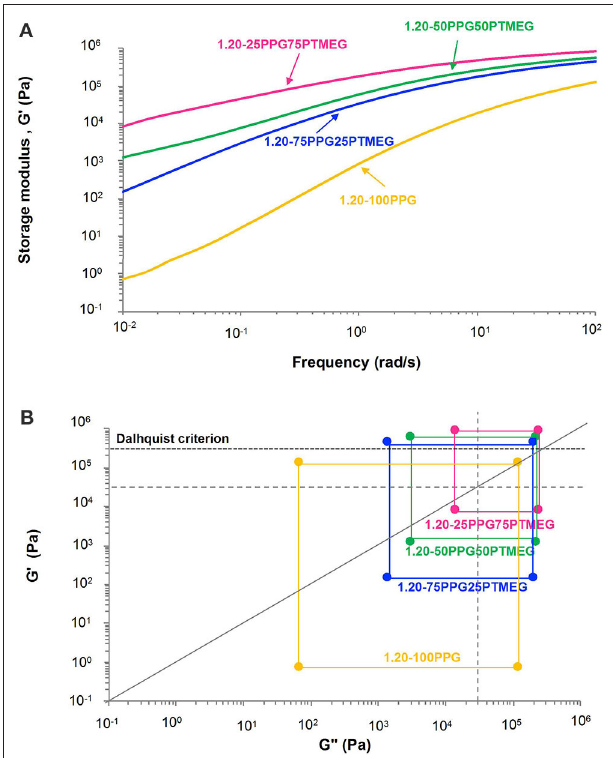
FIGURE 8 | (A) Variation of the storage modulus (G ′ ) at 25 ◦ C as a function of the frequency and (B) Chang’s viscoelastic windows at 25 ◦ C of the TPUs synthesized with different PPG + PTMEG blends. NCO/OH ratio = 1.20. The four regions of Chang’s viscoelastic window are shown as dotted lines, and the dashed line corresponds to the Dahlquist criterion.